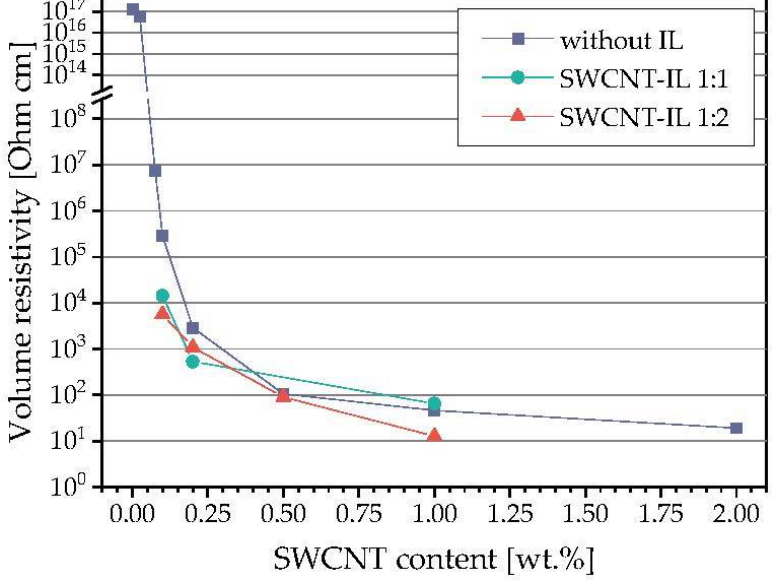
Figure 2. Volume resistivity in dependence on SWCNT content without and with IL (used IL: AMIM Cl).